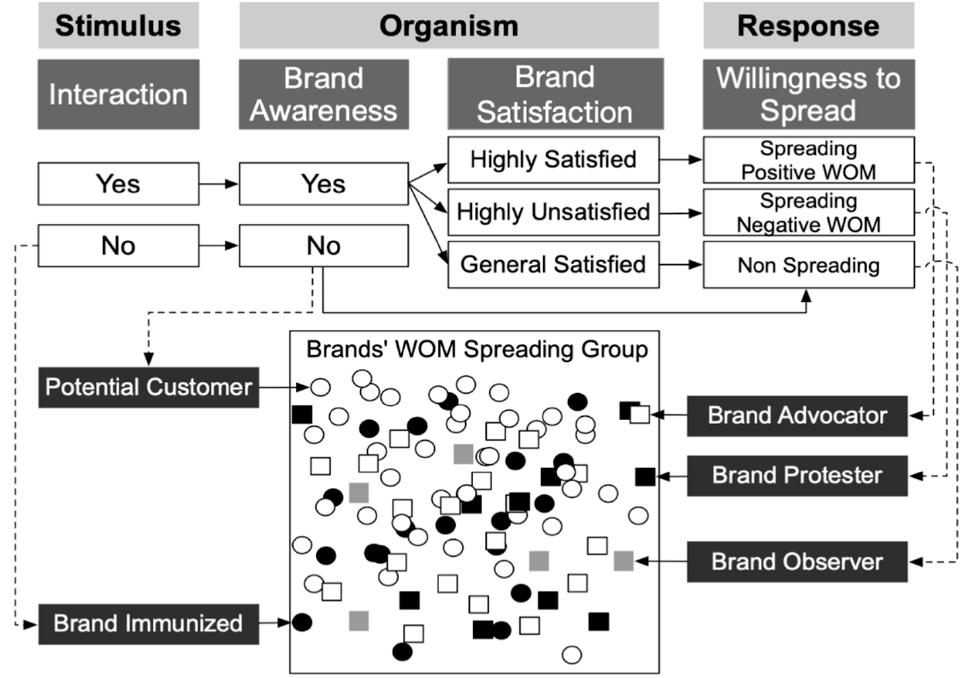
Figure 1. Social media consumer brand online word-of-mouth (OWOM) communication stimulus–organism–response (SOR) model.